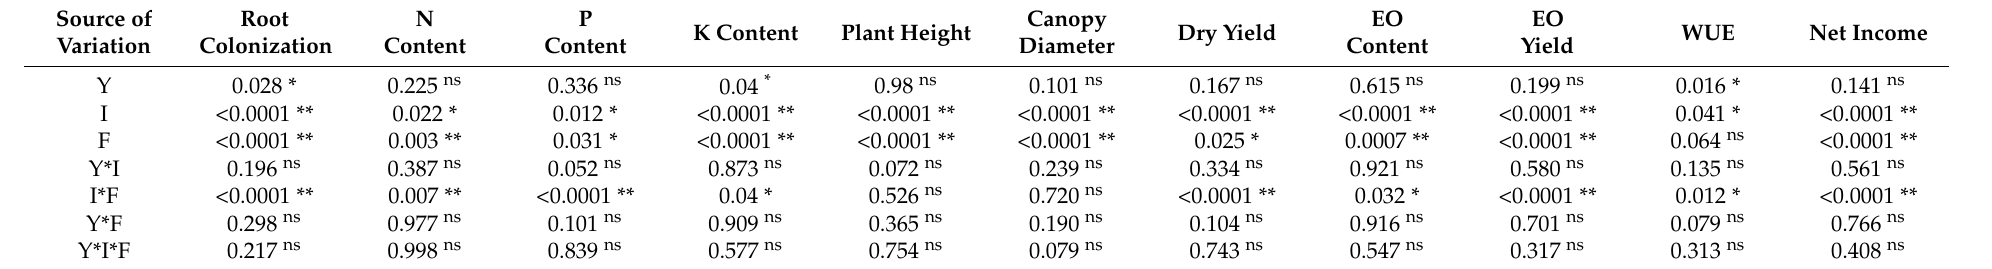
Table 1. The ANOVA ( p -value) results of root colonization, nutrient content, agronomic traits, dry yield, essential oil content and yield, water use efficiency, and net income of peppermint affected by experimental factors.